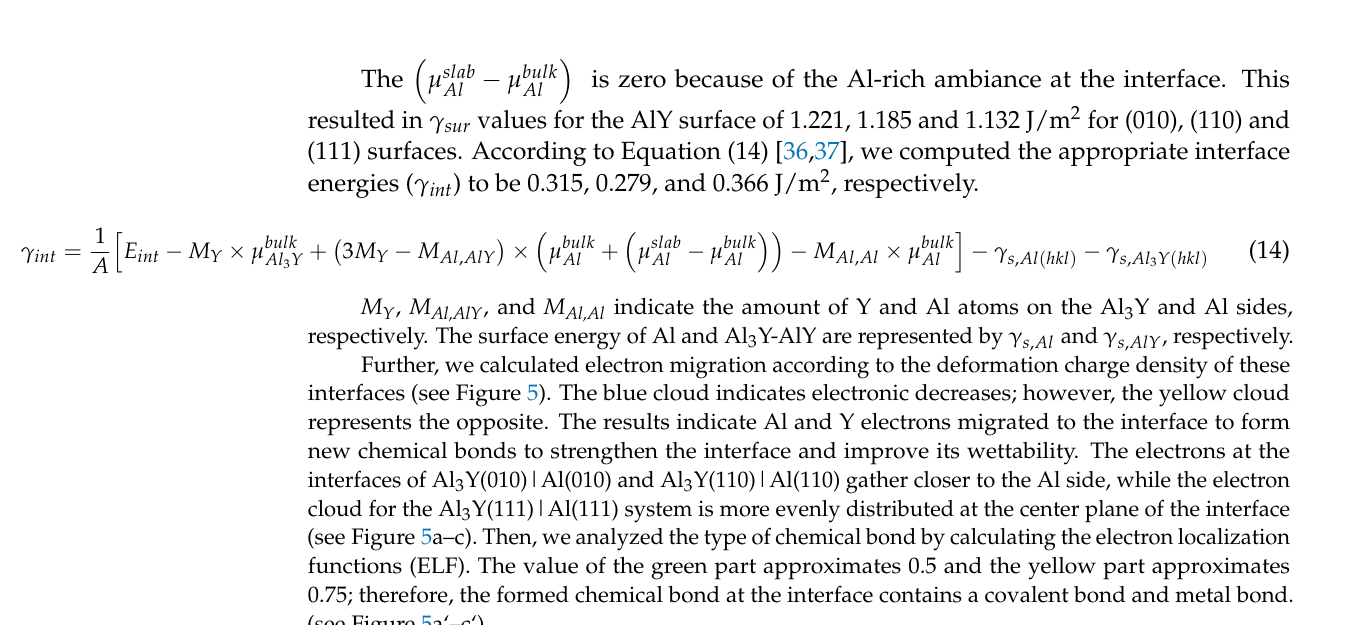
Figure 6. PDOS of Model2 of Al 3 Y(010)|Al(010) interface.